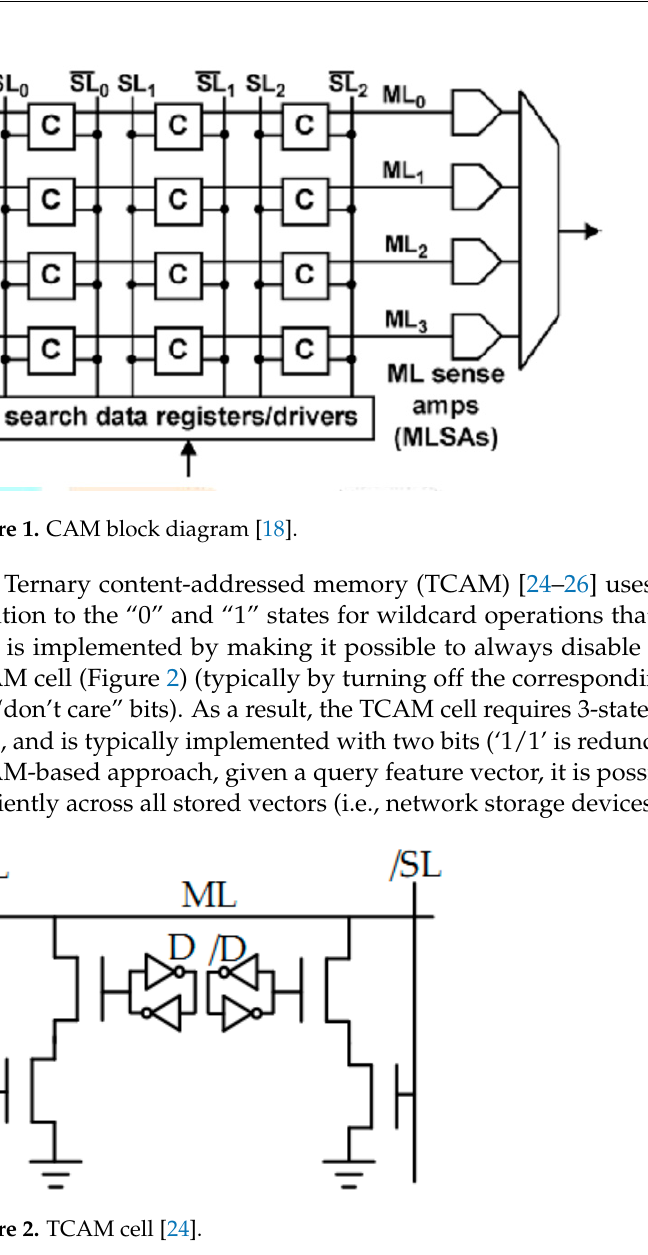
Figure 2. TCAM cell [24].